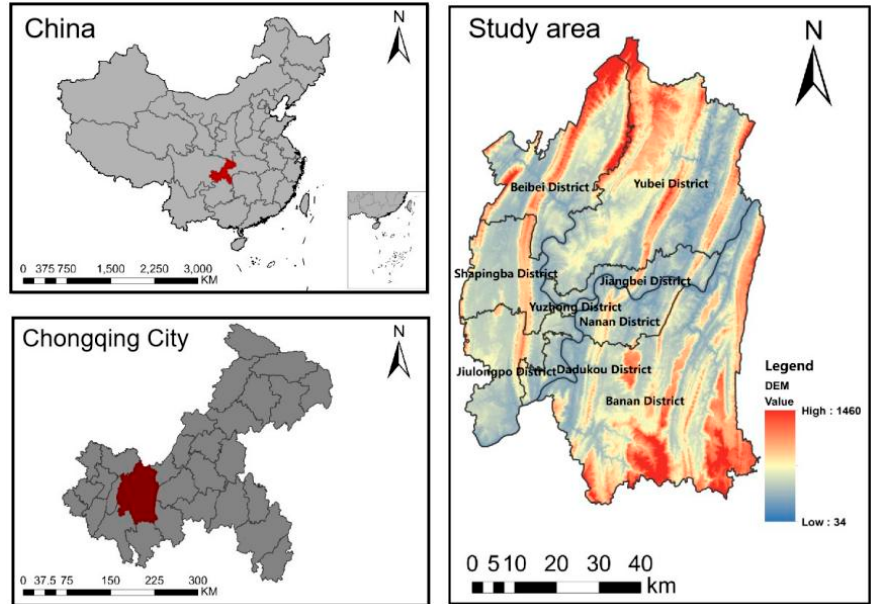
Figure 1. Situation of the study cases.